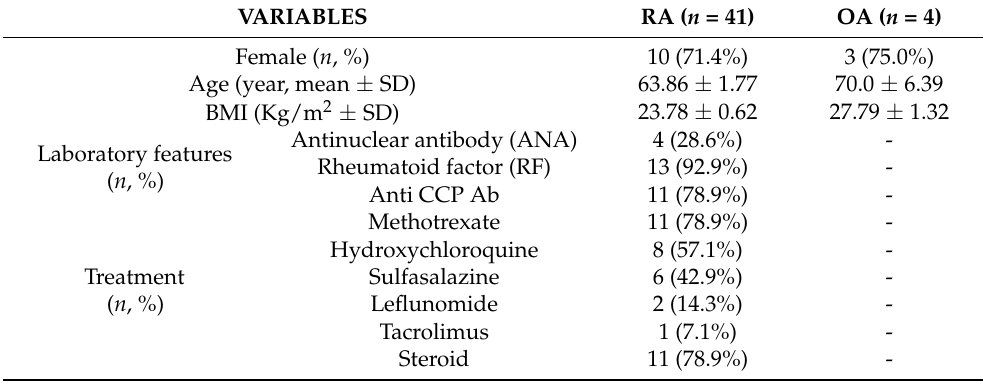
Table 1. Baseline characteristics of all